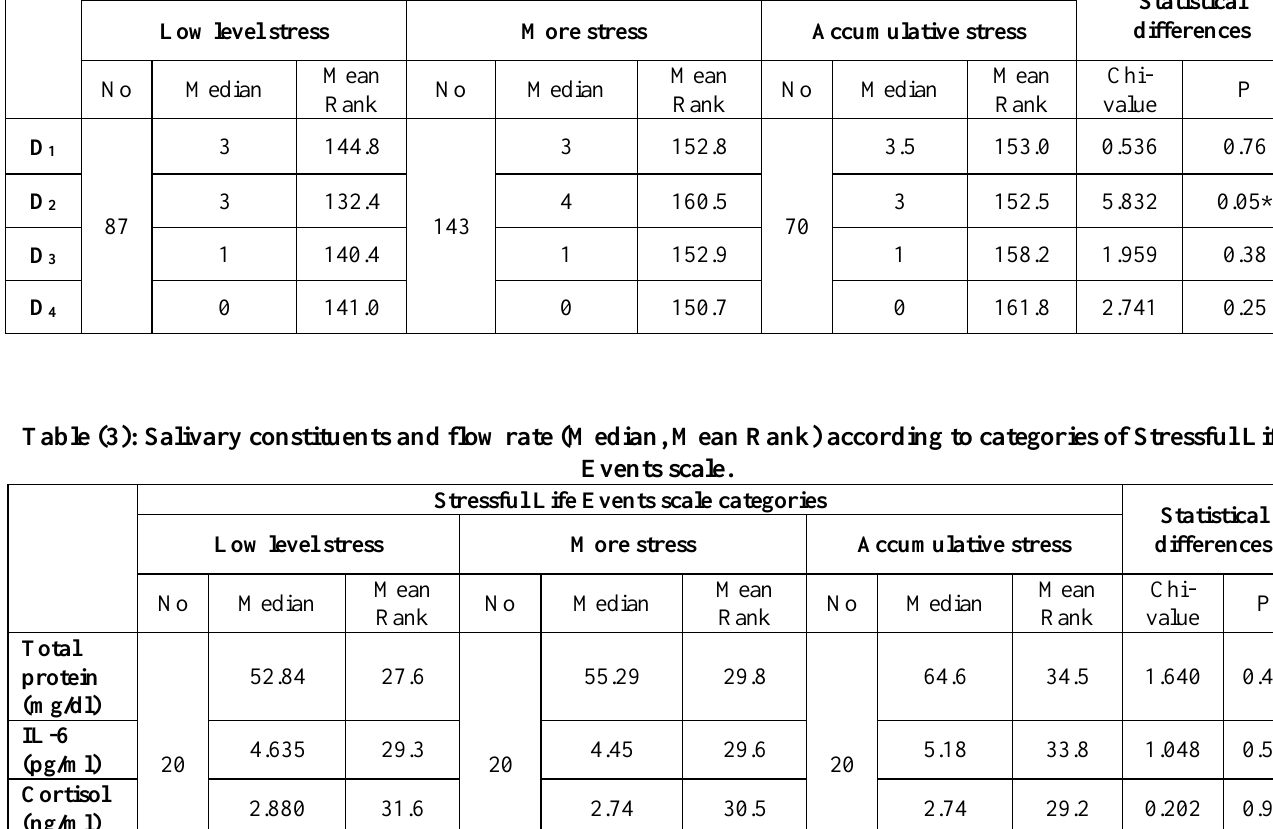
-D ) (Median, Mean Rank) 1 4